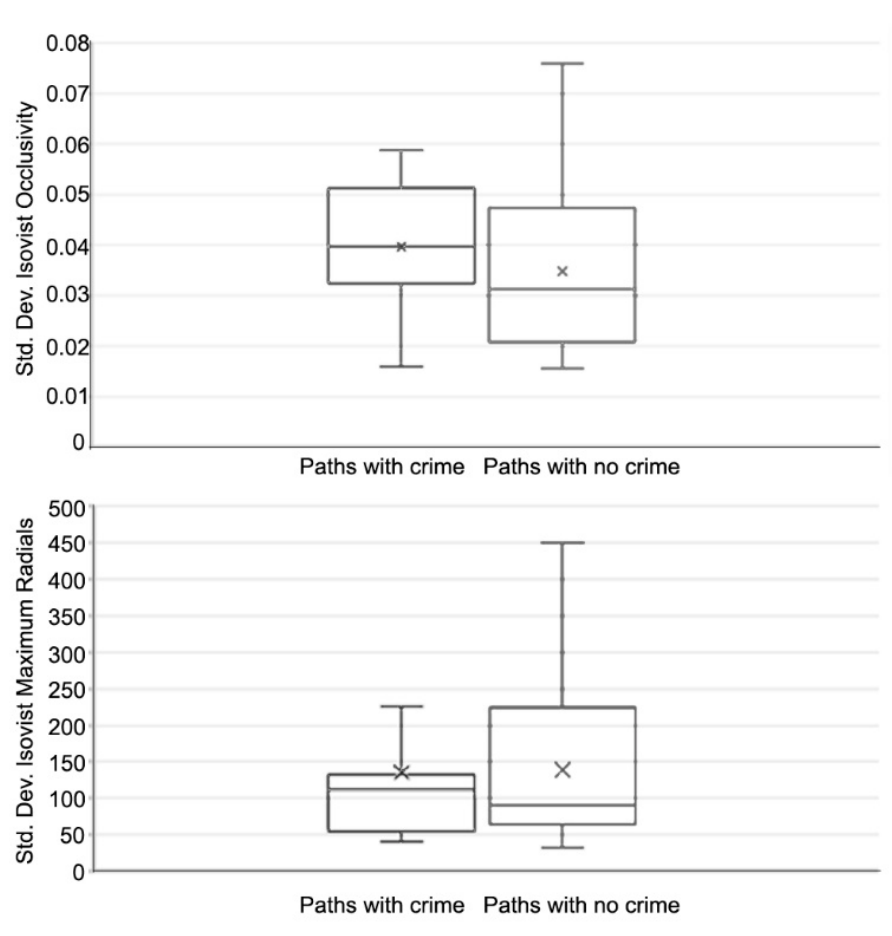
Figure 3. Boxplots comparing the standard deviation for Isovist Max Radial and the standard devia- tion for Occlusivity for paths containing crime against paths with no crime in all three neighborhoods. In addition to the use of negative binomial regression to analyze the data, the re- searchers augmented their analysis by examining the isovist characteristics and physical conditions around each crime incident location across all pathways. Using Google Earth 2D and 3D satellite imagery and videotapes of on-site visits to these neighborhoods, it was observed that occlusivity tends to vary largely based on the location of garages, and any gaps or other openings between walls/fences. Occlusivity tends to increase at locations where the garage of the house is located towards the back of the property (particularly for ones with narrow entrances). When the garage is located flush with the house, occlusivity